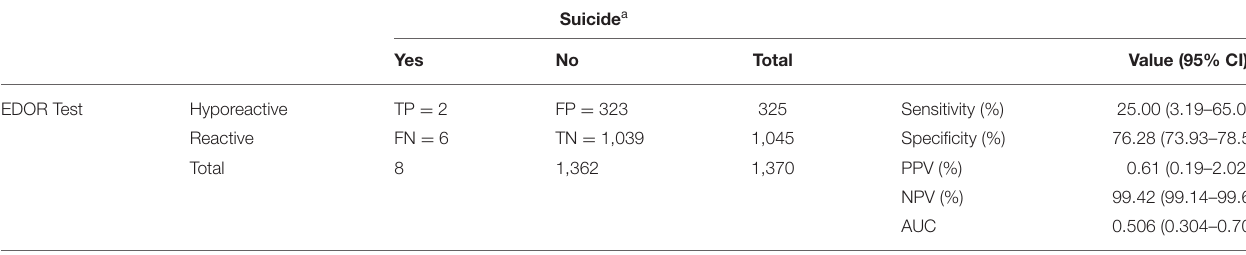
TABLE 6 | Sensitivity, specificity, and AUC of ElectroDermal Orienting Reactivity (EDOR) test and suicide.